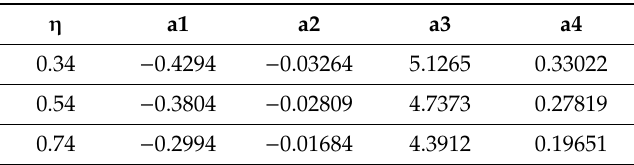
Table 2. Coe ffi cient of